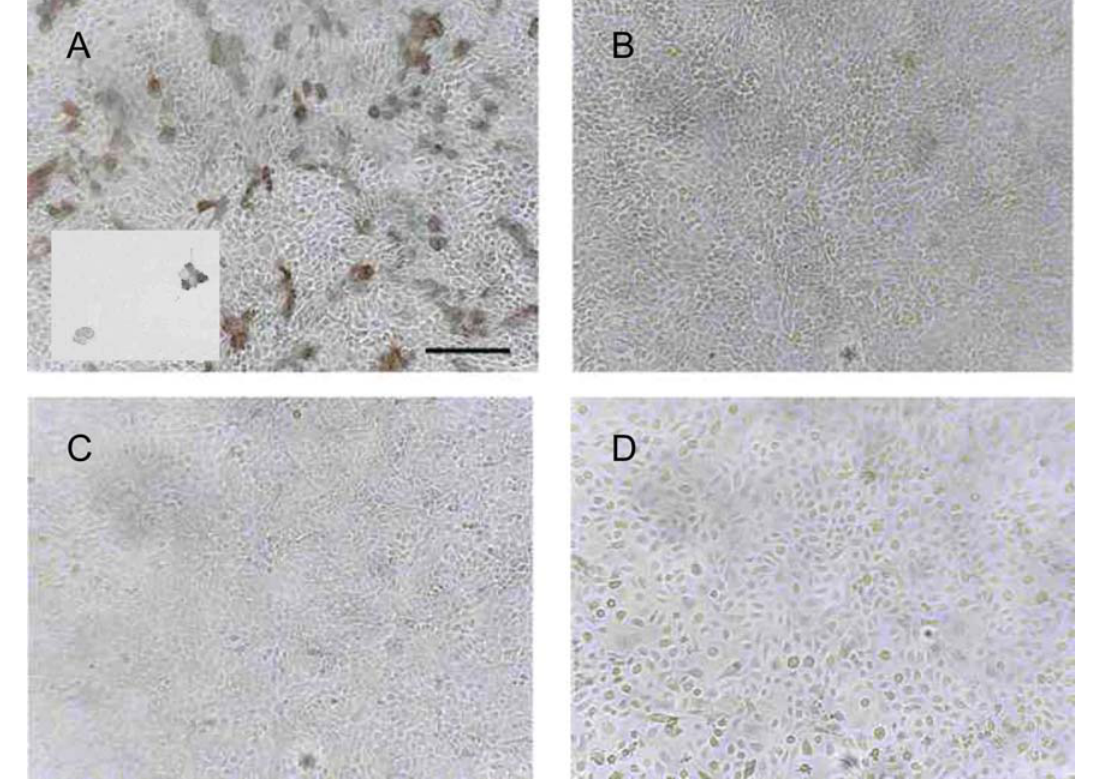
Figure 7. Cobalt histochemistry did not show functional TRPV1 in keratinocytes. A: TRPV1 e /HaCaT and rat DRG culture (insert) treated with 50 m M RTX in the presence of cobalt cations shows dark CoS precipitate. B: TRPV1 e /HaCaT without RTX C–D: HaCaT and NHEK treated with 50 m M RTX did not produce the characteristic precipitate formed in the presence of intracellular cobalt cations. Bar represents 0.2 mm.